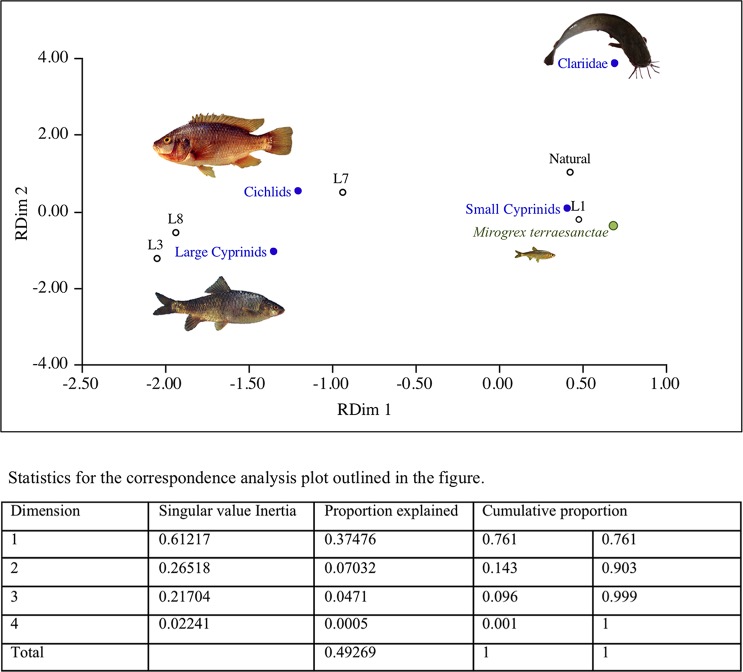
Correspondence analysis of taxonomic groups’ relative abundance (%) in the natural accumulation and at Loci 1, 3, 7, and 8.